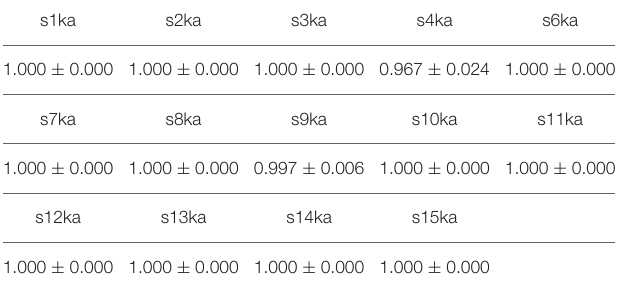
TABLE 3 | Accuracy of the two-class classification by SVM with the CSP log-variance